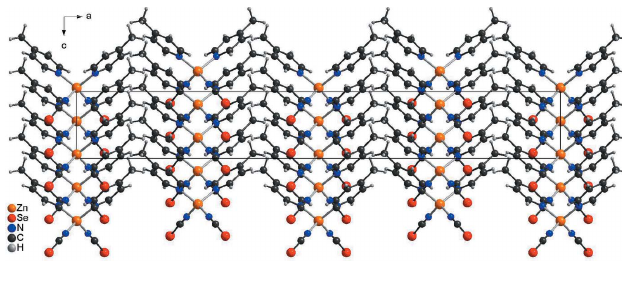
Figure 4 Crystal structure of compound 1 viewed along the b -axis direction.